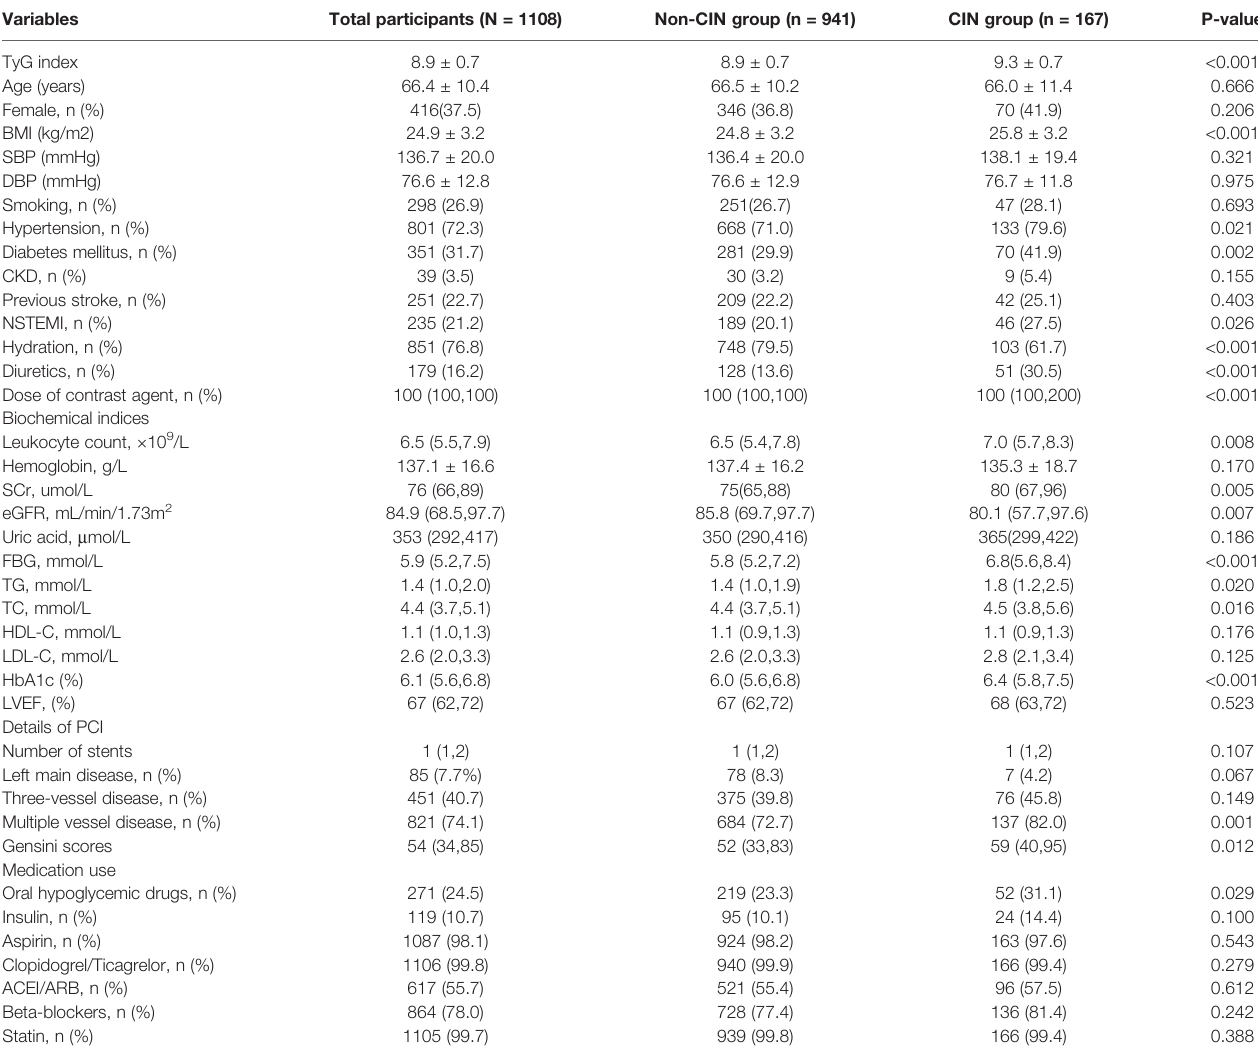
TABLE 1 | Baseline characteristics of the total participants.